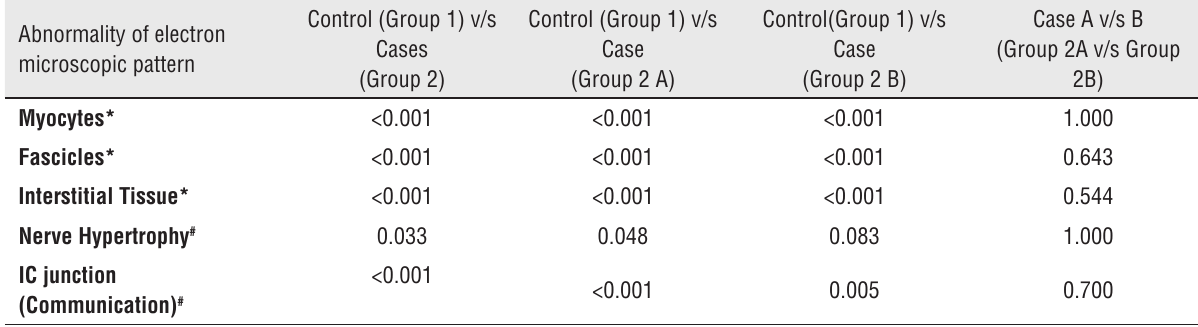
Table 3 - Statistical correlation of electron microscopic findings in various groups. Abnormality of